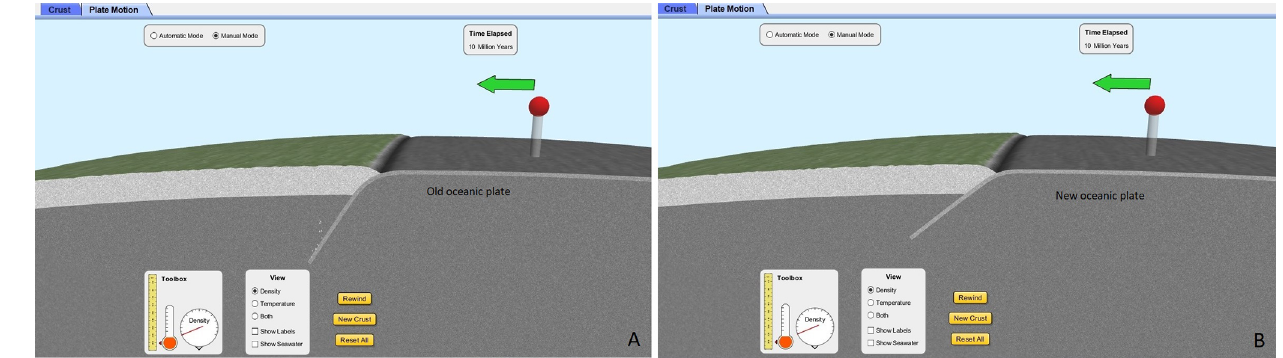
Figure 5. Subduction angles resulting from the collision between a plate with continental crust and an old oceanic plate (a) and a new oceanic plate (b) . Caption from PhET™ Plate Tectonics.